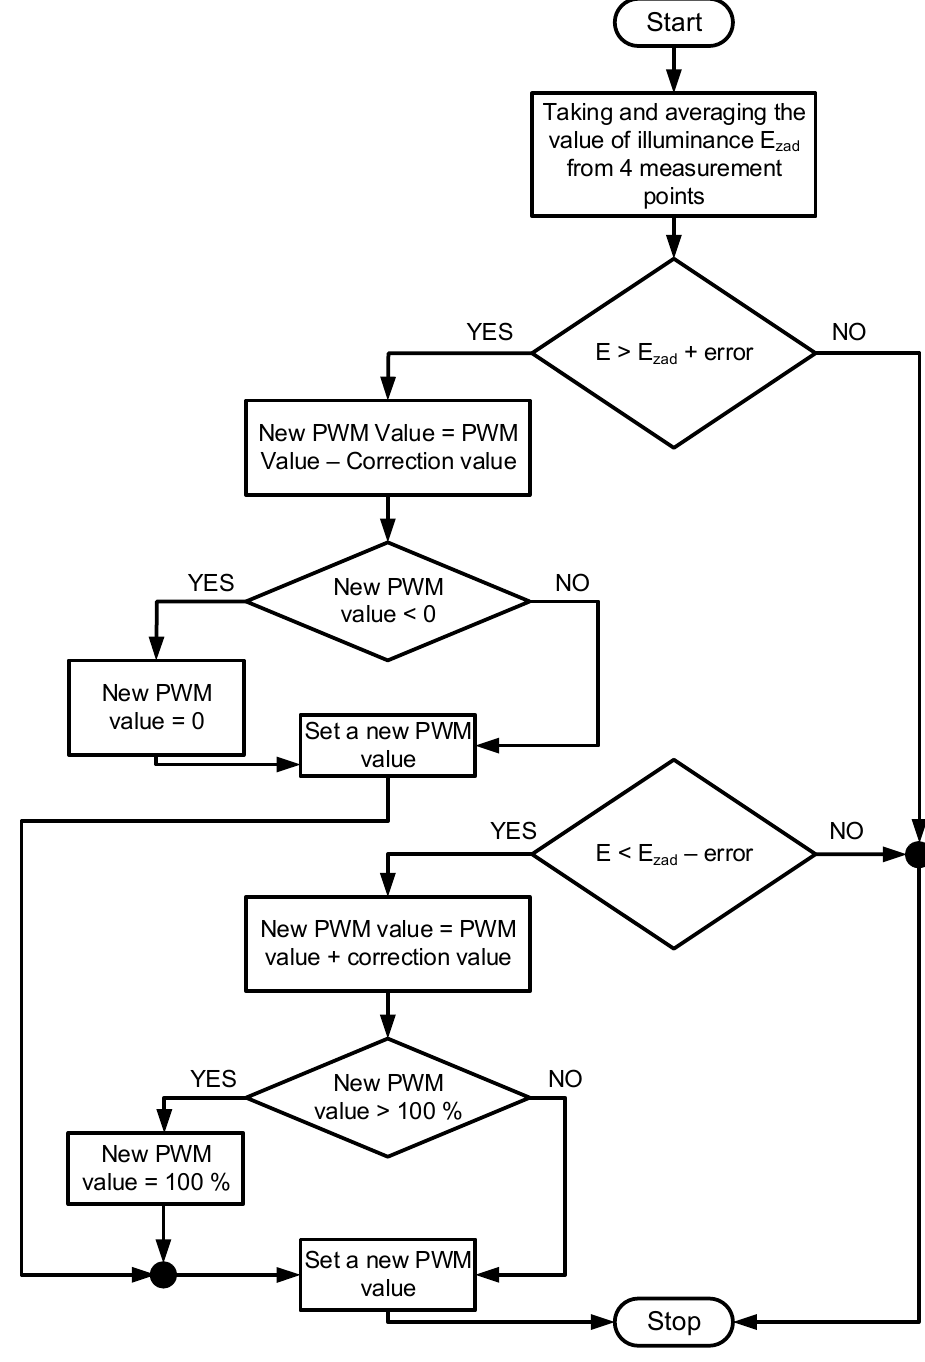
Figure 6. Control system operation algorithm.